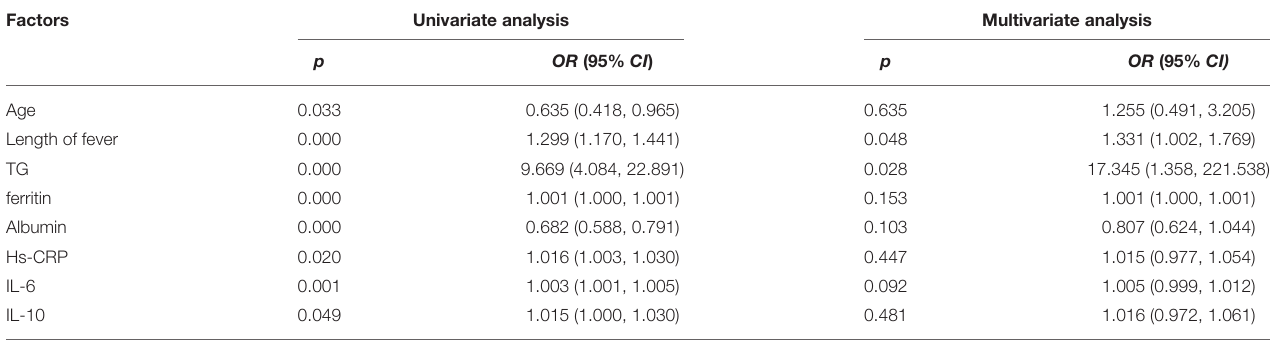
TABLE 2 | Logistic regression analysis of risk factors for SAP to develop HLH. Factors Univariate analysis